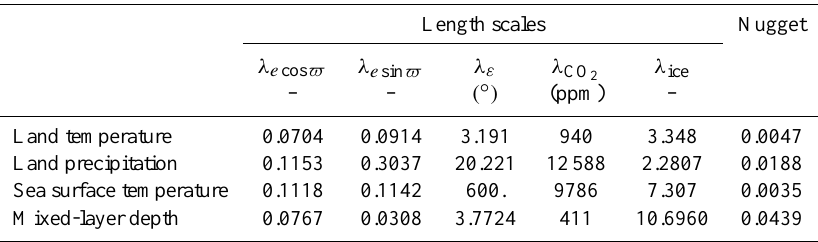
Figure 5. Diagnostic of emulator performance considering experiments 11 and 40. Shown are the mean and standard deviations of sea-surface temperature (left panel) and mixed-layer depth (right panel). Clearly seen are the two bad predictions, especially in the case of sea-surface temperature. Table 2. Emulator scales for the different fields under study. In general, scales are commensurate with the range covered by the input factors. However, for CO 2 and sometimes obliquity, the scales are much larger than the fields’ scale. This simply indicates that the response is linear with respect to the